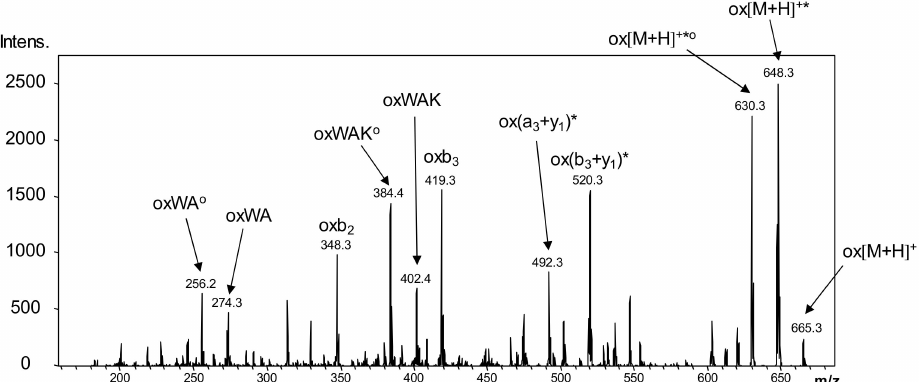
Figure 9. LC-MS/MS fragmentation profile of the oxidized Ac-c(CWAKC)-NH 2 peptide, confirming the location of the site of oxidation on the Trp residue. The spectrum was acquired on a Bruker Esquire 3000+ ion trap tandem mass spectrometer. * is used to label the neutral loss of ammonia, o is used for water loss. Fragment ions in brackets are connected through a disulfide